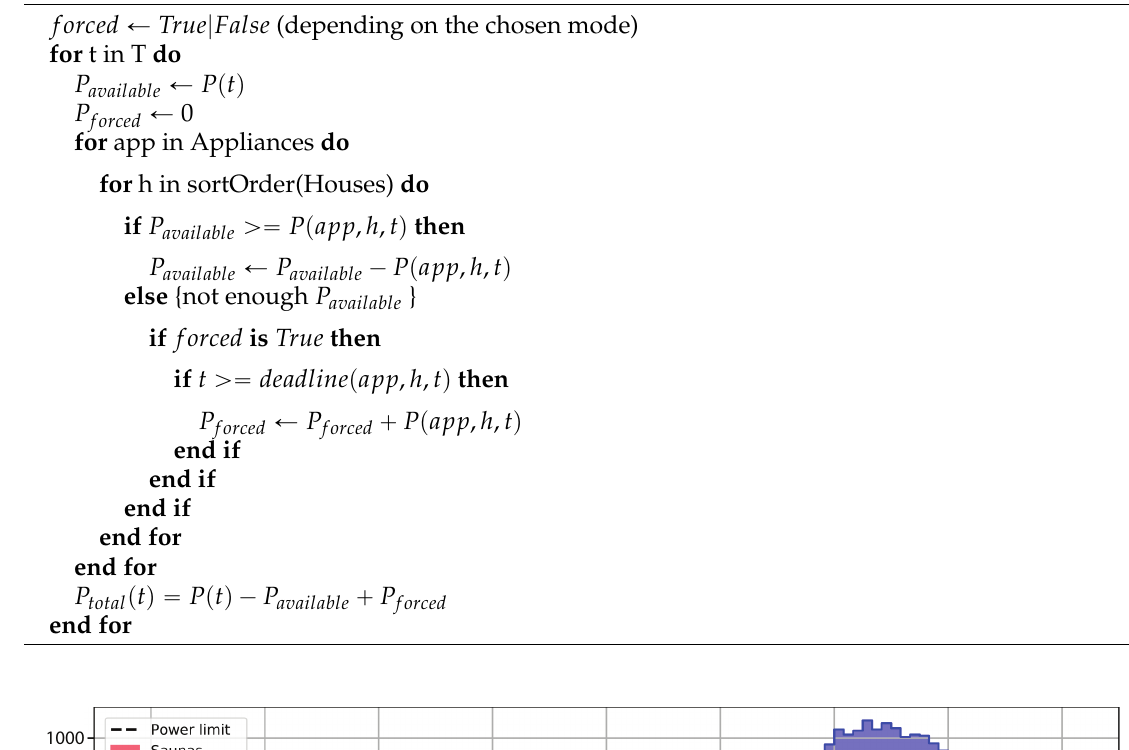
Algorithm 1 Load allocation